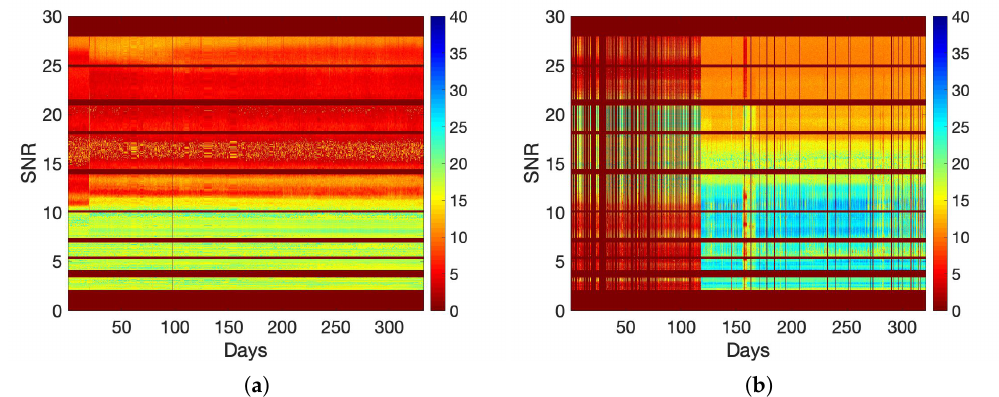
Figure 3. SNR color map for the in-field collected data. ( a ) Data Set Exp MV ; ( b ) Data Set Exp LV . We identify three main categories of anomalies, similar to those in [58], which are, concentrated faults, distributed faults (DFs), and abnormal termination impedance